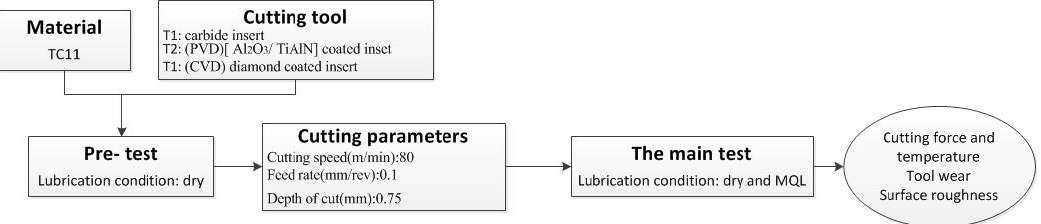
Figure 2. Global scheme of the experiment.